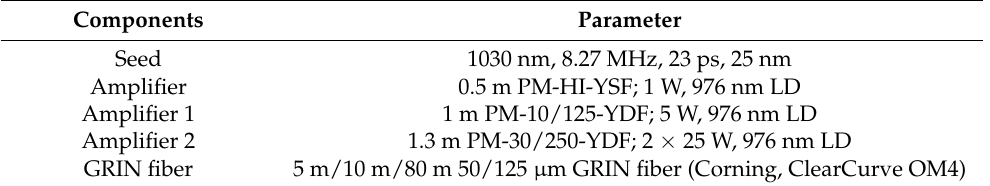
Table 1. The parameters of components in the